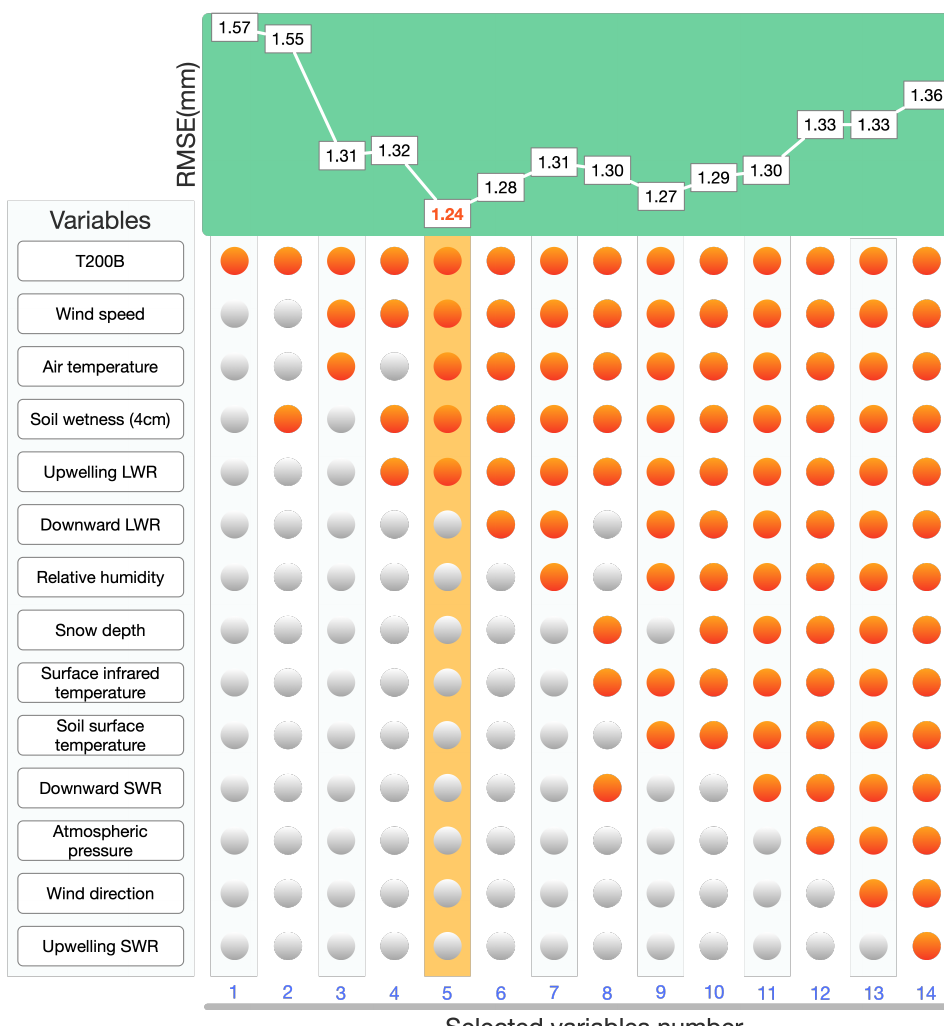
Figure 6. The change of RMSE according to different variable combinations in the XGB regression method. There are 14 columns in which the selected variables are marked orange. The number of selected variables increased from 1 to 14 along the X-axis. The corresponding RMSE is noted at the top of each